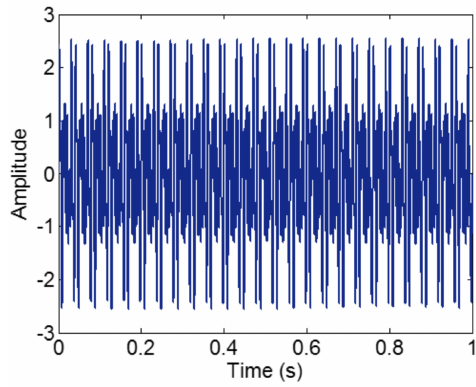
Figure 1. The waveform of the sample signal f sig 1 between in time domain.